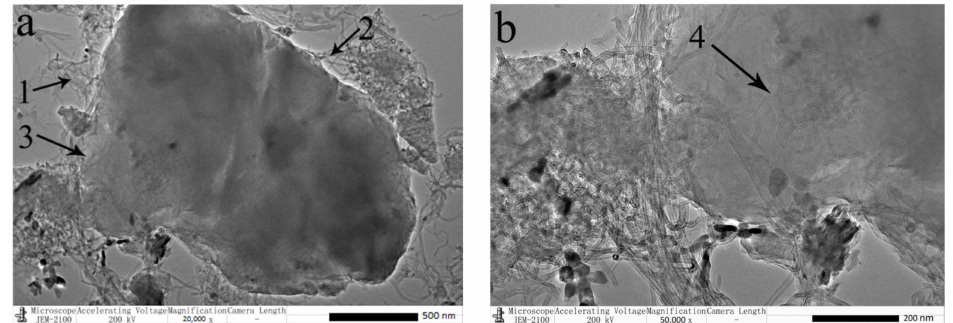
Figure 2. TEM images of CNT/WPRP mixtures ( a ) × 20,000 ( b ) ×